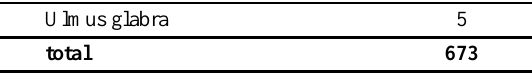
Table 1. Number of test trees of different